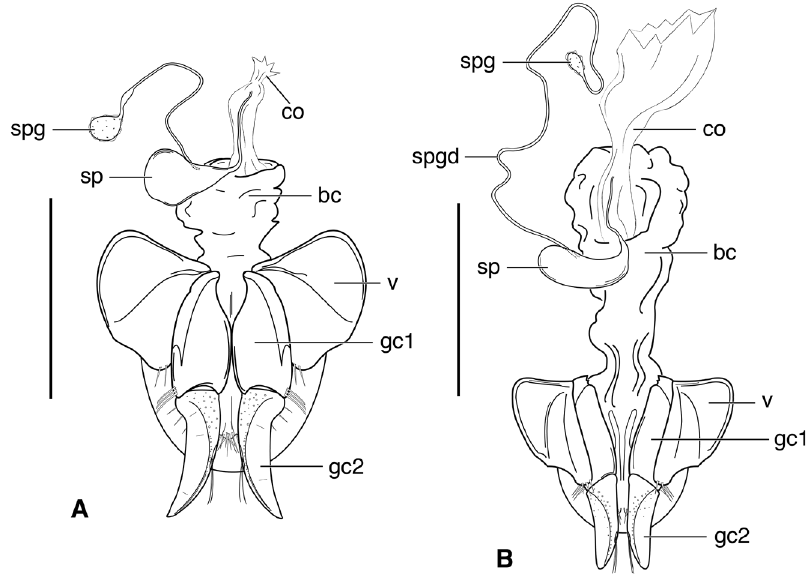
Figure 52. Line drawing of female reproductive tract of Selenophorus palliatus species group, in part, ventral aspect. A S. pyritosus Dejean B S. woodruffi Ball & Shpeley. Legend: bc bursa copulatrix; co common ovi- duct gc1 gonocoxite 1 gc2 gonocoxite 2 sp spermatheca spg spermathecal gland spgd spermathecal gland duct v valvifer. Scale bars 1 mm.